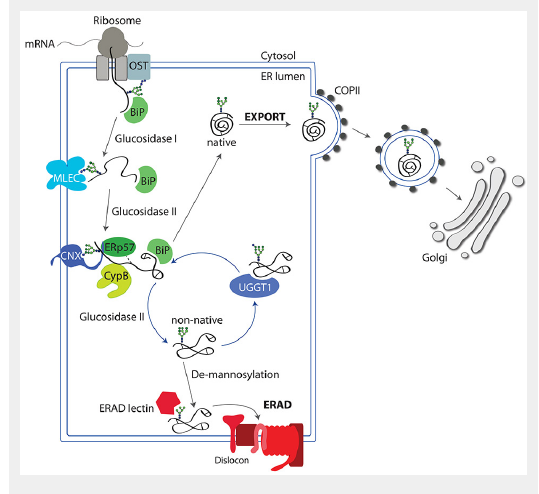
Folding cycle in the ER. The nascent polypeptide arising from the ribosome is translocated into the ER lumen. The polypeptide is co- translationally N-glycosylated by the OST. Hydrophobic patches exposed by the not-yet native polypeptide are shielded by molecular chaperones such as BiP to prevent aggregation. Upon removal of the outermost glucose residue by glucosidase I, the lectin malectin binds to the N-glycan. Removal of the second glucose residue by glucosidase II, allows recruitment of CNX (or CRT) and the associated folding enzymes (the oxidoreductase ERp57 and the peptidyl-prolyl cis/trans isomerase CypB that catalyse the rate-limiting steps of the folding programme leading to the attainment of the correct configuration of disulfide and peptidyl- prolyl bonds, respectively). The polypeptide is eventually released from CNX, the third glucose residue is removed by glucosidase II, and the polypeptide structure is inspected by the folding sensor UGGT1. Native proteins are exported to the Golgi in COPII-coated vesicles. Non-native polypeptides are re-glucosylated by UGGT1 and sent back to the CNX folding platform. Terminally misfolded polypeptides are extensively de-mannosylated and dislocated across the ER membrane to be degraded by cytosolic proteasomes in processes collectively defined as ER-associated degradation